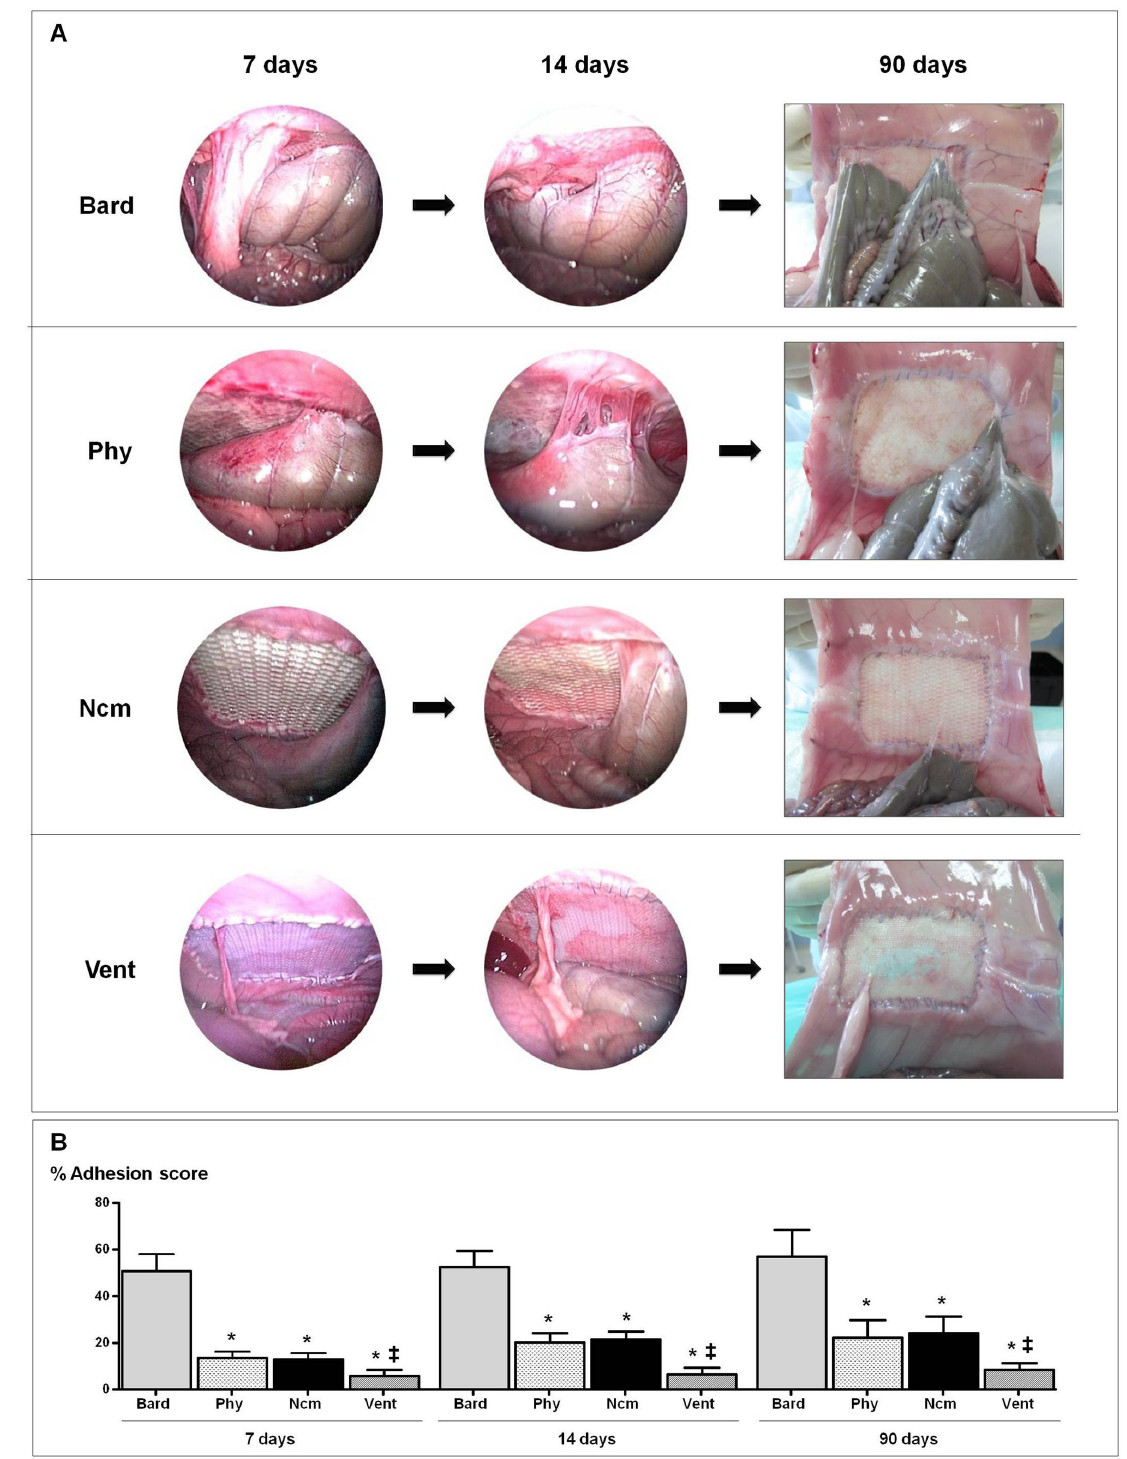
Figure 2. Laparoscopy study. A) Sequential laparoscopy tracking of adhesions 7, 14 and 90 days after implant in the groups: Bard mesh TM , Physiomesh TM , the composite mesh and Ventralight TM . B) Percentage prosthetic areas covered by tissue adhesions recorded for each group. Physiomesh TM (Phy), new composite mesh (NCM), Ventralight TM (VL). (*p<0.05 versus Bard; ‡p<0.05 versus Phy and NCM). doi: 10.1371/journal.pone.0080647.g002 PLOS ONE |